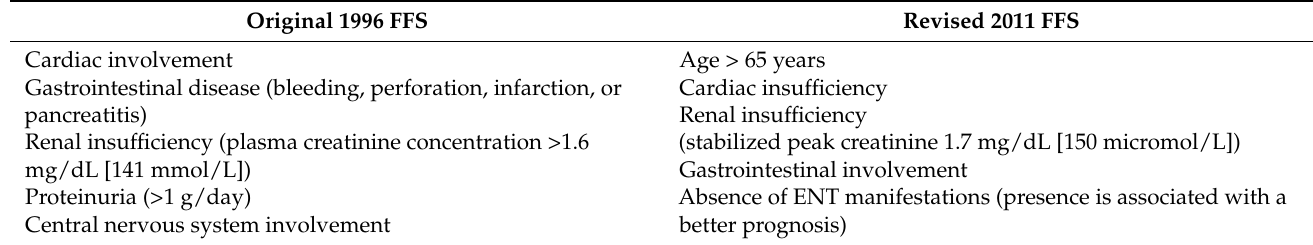
Table 1. Comparison of 1996 and 2011 five factor score (FFS)